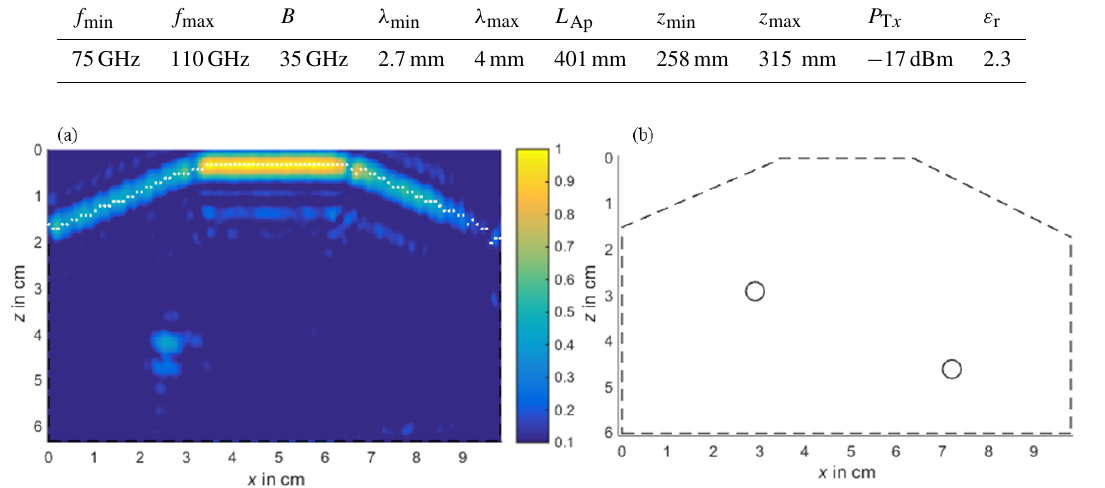
Figure 5. (a) Free-space reconstruction and detected object contour (white); (b) ideal geometry sketch of the object under test.